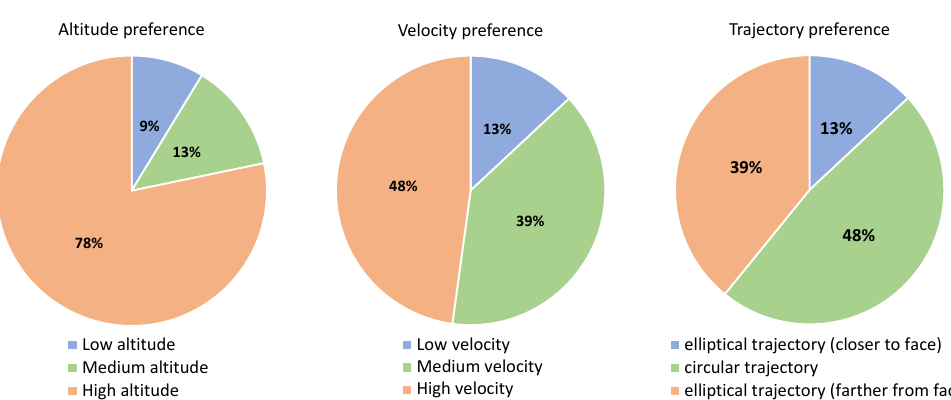
Figure 10. User preference for each of the variables measured for the experiment with younger